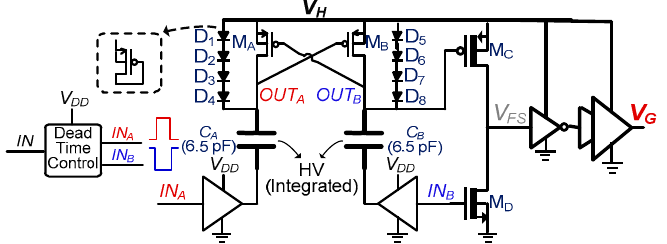
Figure 8. High-voltage level shifter (HVLS) for bi-directional switches between PZTs and inductor.